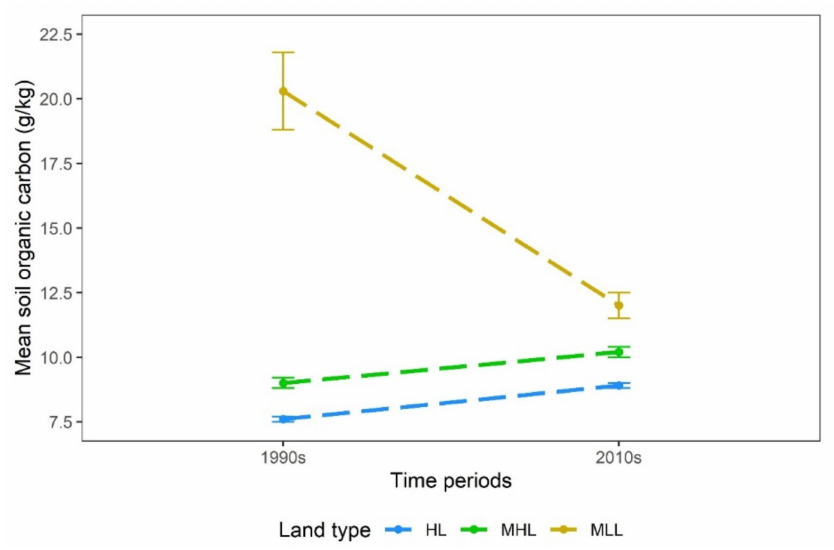
Figure 4. The effect of soil sample collection period (1990s, 2010s) on SOC contents (0–15 cm) in the land types (highland = HL, medium highland = MHL, medium lowland =